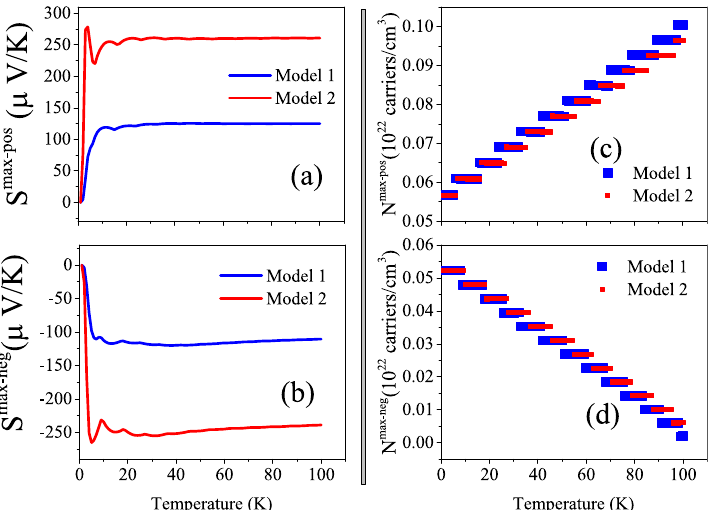
Figure 2. ( a ) Maximum positive or hole-like of spin up Seebeck coefficient ( S max − pos ) and ( b ) maximum negative or electron-like of spin up Seebeck coefficient ( S max − neg ) of hole/electron doped CeIn 3 versus temperature calculated by B3PW91- α = 0.20 at P = 0 using the τ = τ 0 ǫ ( r − 1 / 2 ) model with τ 0 = 5 , r = 2 (Model1) and r = 4 (Model2). Doping levels related to the ( c ) S max − pos and ( d ) S max − neg .